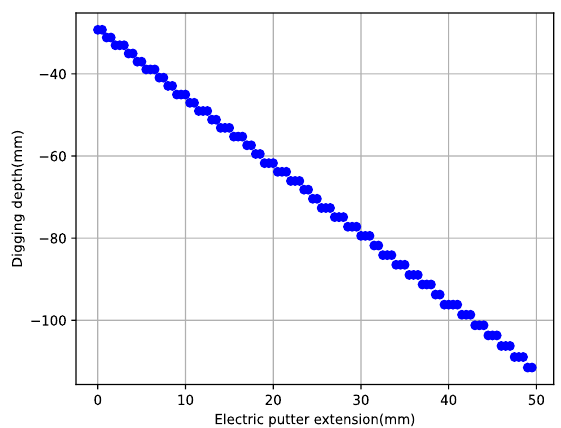
Figure 10. Coordinate change curve of point C.